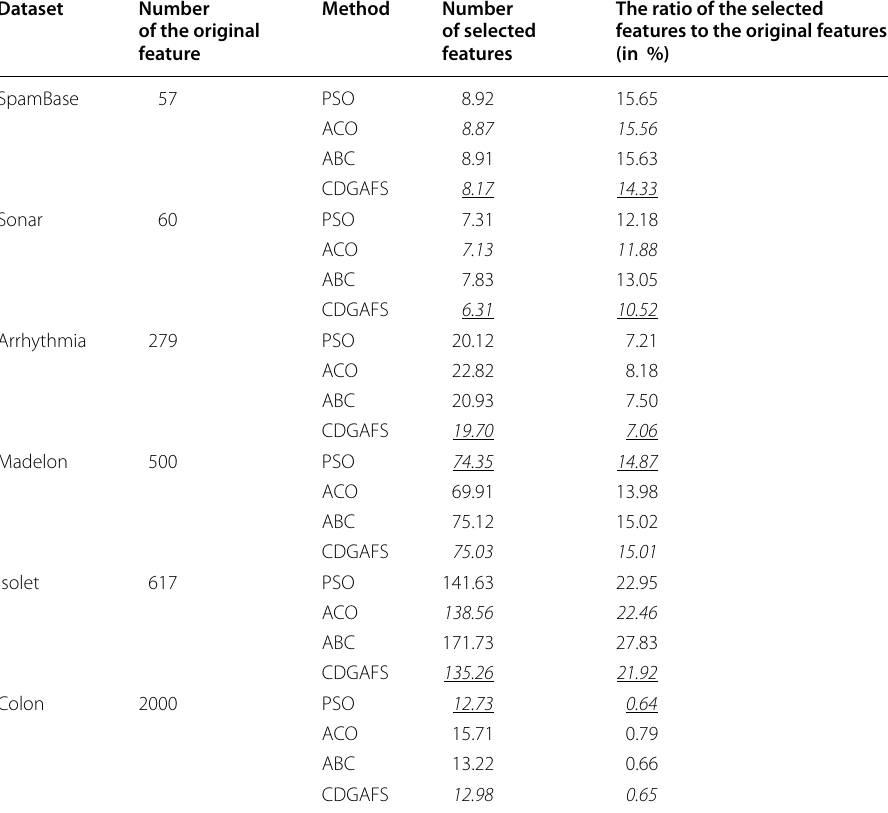
Table 4 Average number of selected features of the different wrapper evolutionary-based